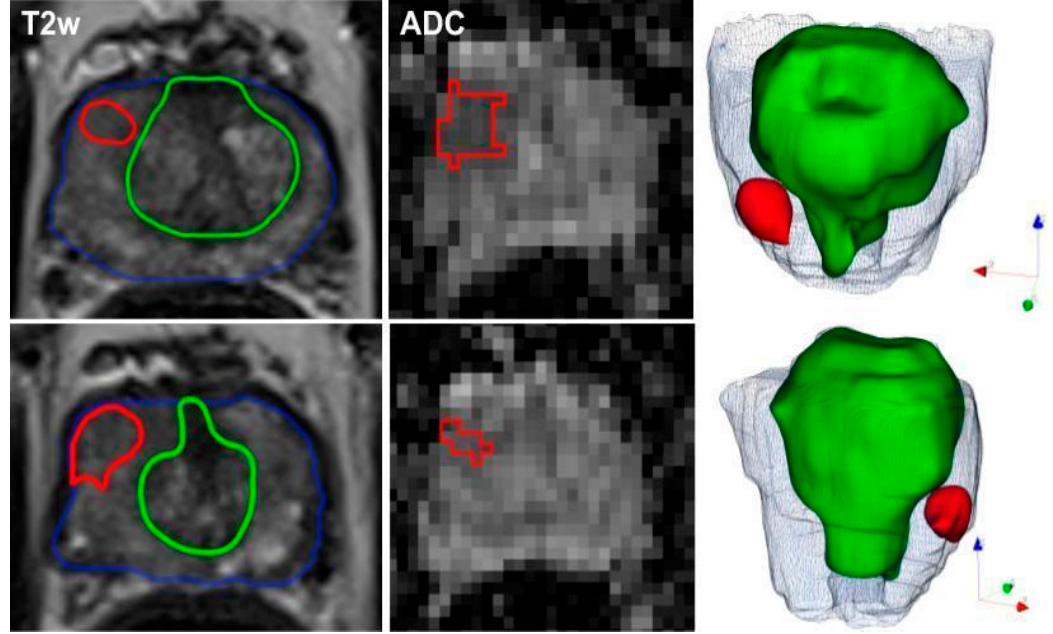
Figure 4. Representative segmentation of a 60-year-old man on axial T2-weighted and ADC-images with an initial prostate-specific antigen level of 12.9 ng/ml, normal DRE result, and a highly suspicious lesion located medio-apically in the right peripheral zone (PI-RADS category 4). Targeted MRI/ultrasound-fusion biopsy confirmed the presence of PCa, Gleason 3+4, ISUP 2. The contours outline the following manual segmentations: blue—whole organ, green—transition zone, red—index lesion.